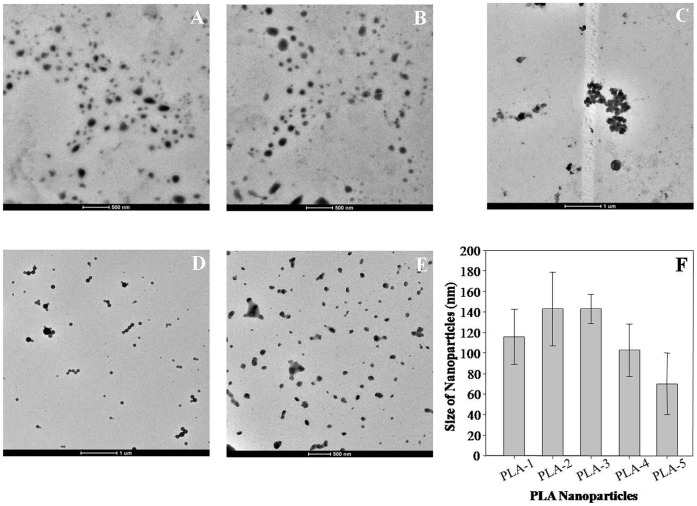
Transmission electron micrographs of PLA NPs synthesized using PEs as stabilizer/emulsifier.(A) PLA-1 (B) PLA-2 (C) PLA-3 (D) PLA-4 (E) PLA-5. A drop of each PEs synthesized PLA NPs were loaded on copper grids, negatively stained with 2% ammonium molybdate and images were recorded on Tecnai T20 twin, TEM at 200 kV. Bar diagram showed the size of various PLA NPs (F).